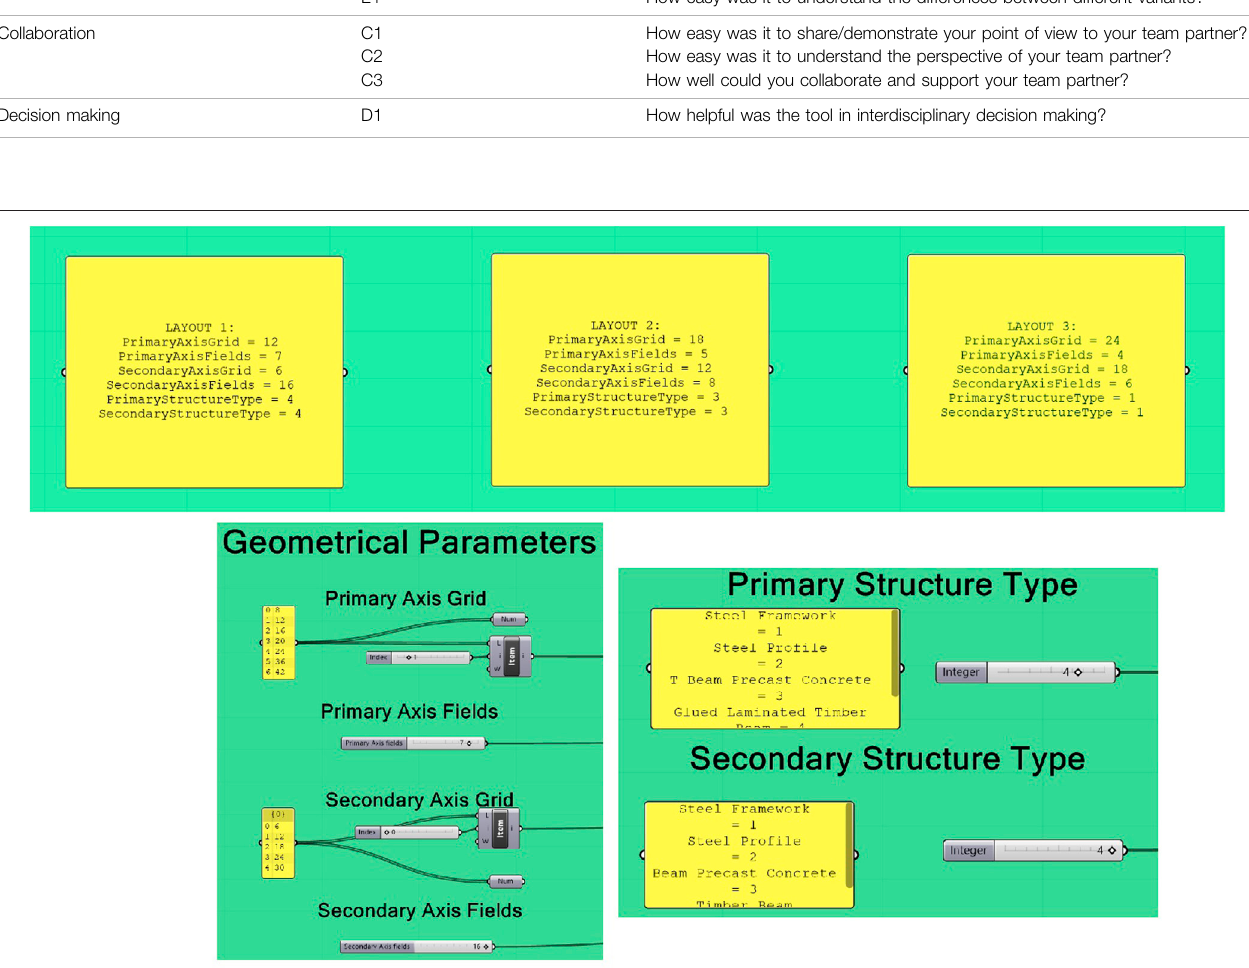
Frontiers in Virtual Reality |